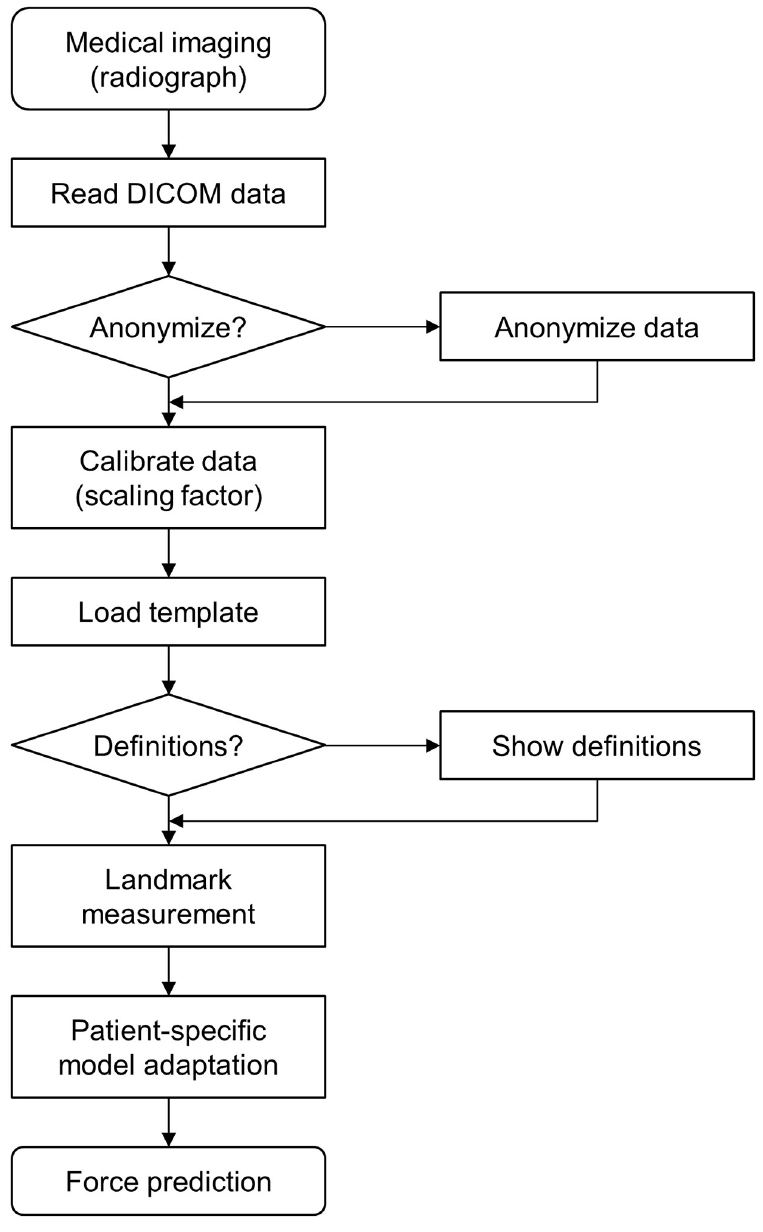
Fig 3. Rule-based protocol for the modelling process. At least three test cycles were performed to reduce learning curve effects.